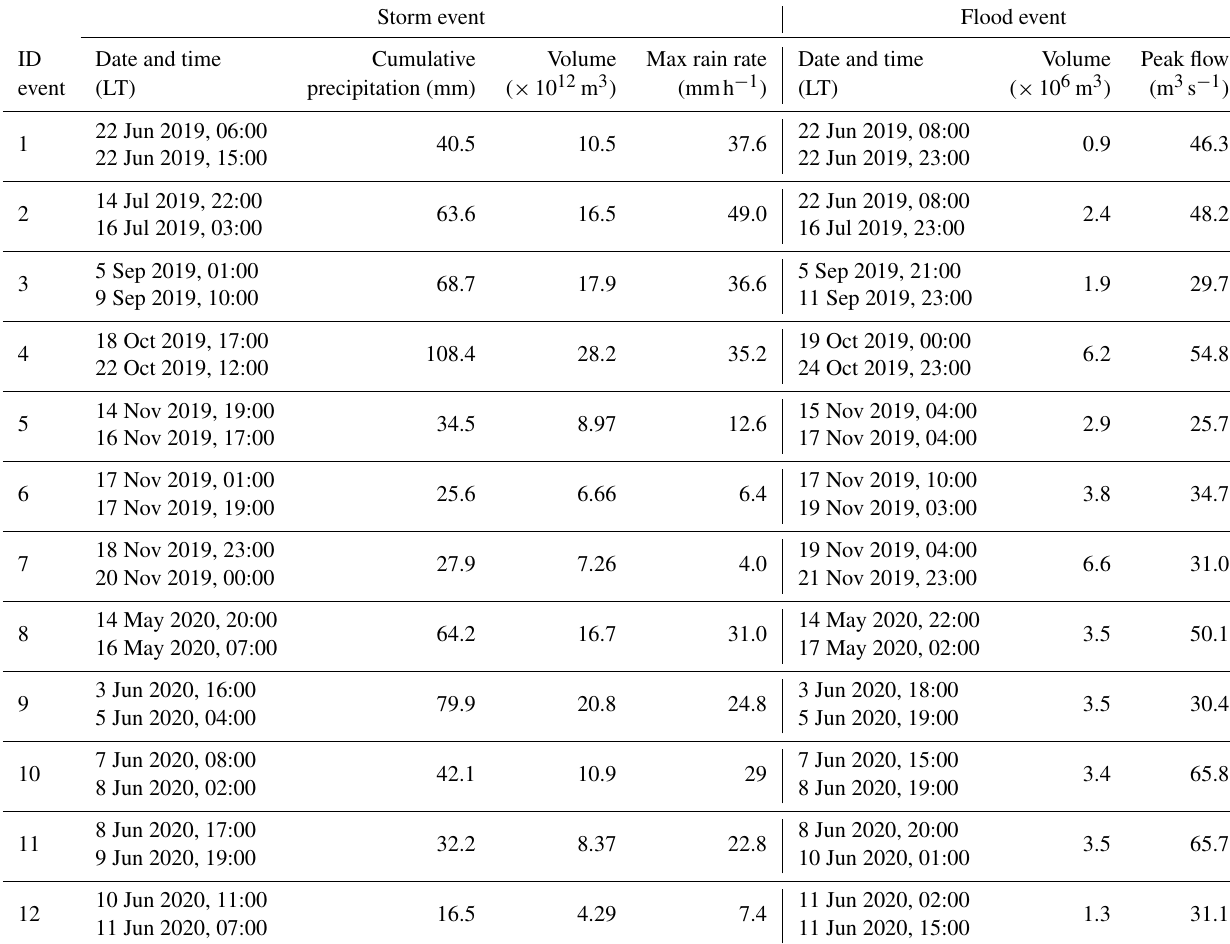
Table 1. Details of the 12 events considered. The date, time, cumulative precipitation, precipitation volume, and 1h maximum rain rate for the 12 storm events are shown on the left, and the date, time, flow volume, and peak flow of the corresponding flood events are shown on the right. Here, LT stands for local